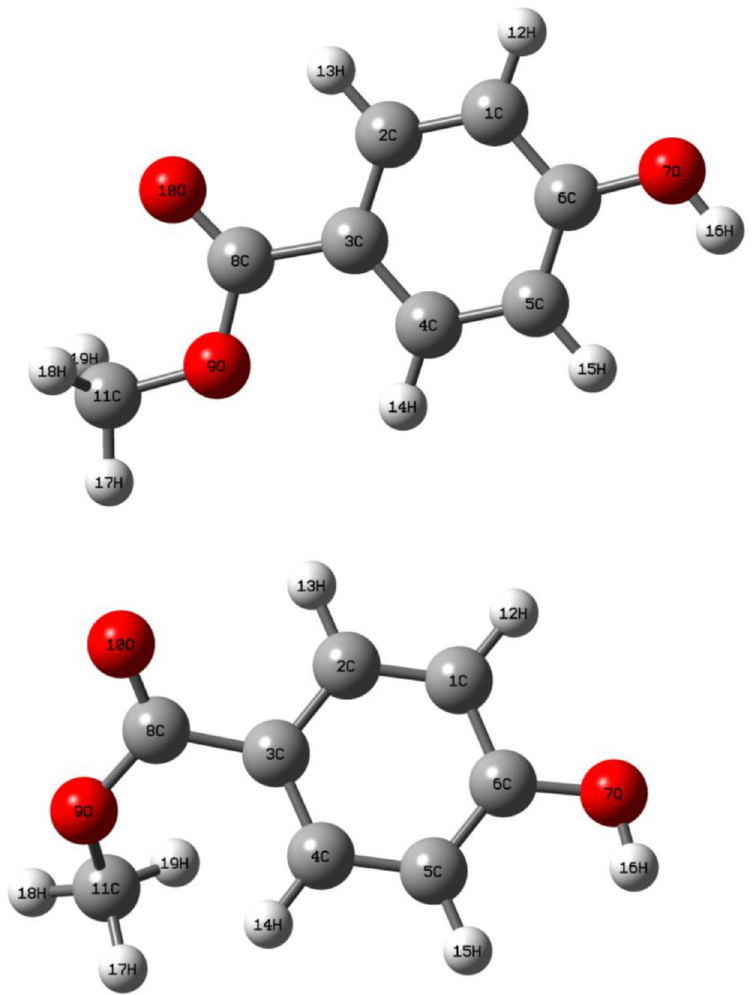
Fig 4. Optimized structure with atomic numbering obtained by the (a) HF and (b) DFT